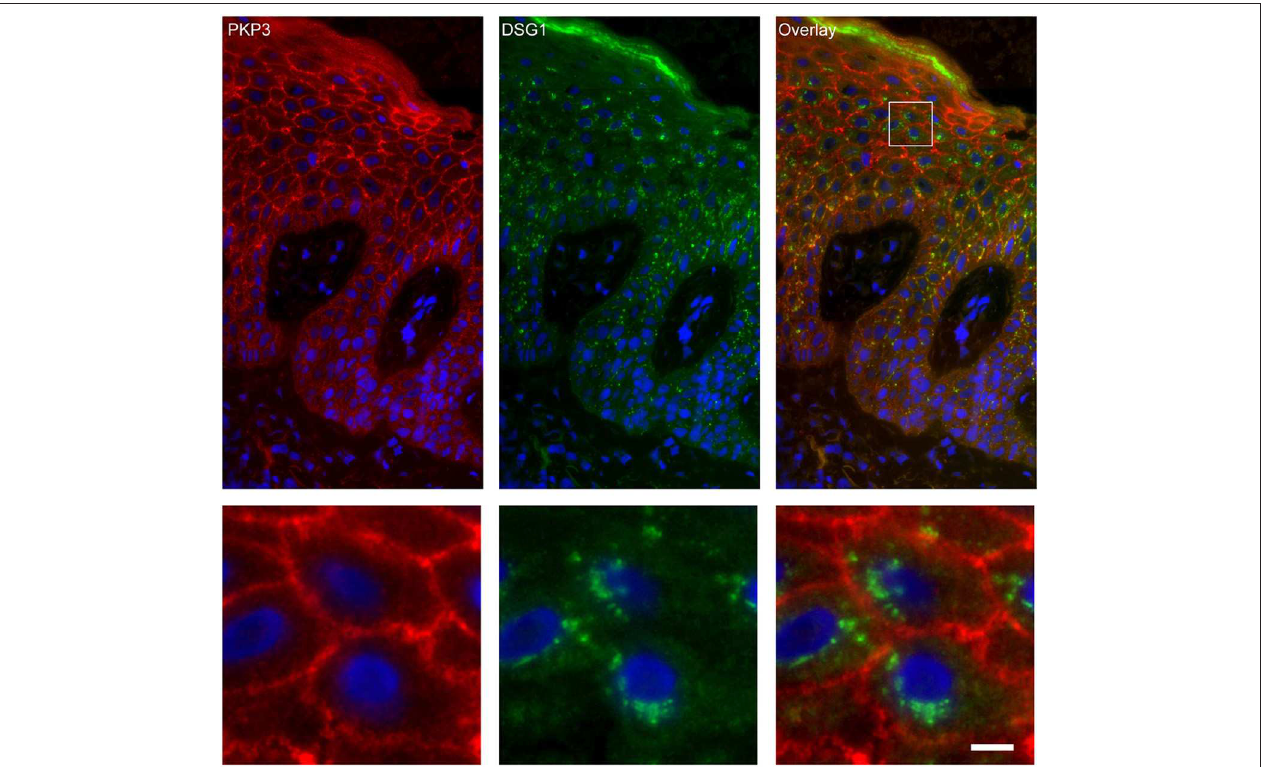
FIGURE 7 | Double staining of desmoglein 1 and plakophilin 3 shows no overlap in endosomes. The upper panel shows the overview, the lower panel shows the detail from the white box in the upper panel. White bar is 5 µ m.